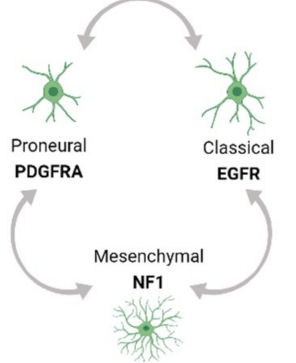
Figure 1. Different transcritptional subtypes of GBM cells and their associated mutations in bold. scRNA seq studies have elucidated three different subtypes of GBM cells namely Proneural (PN), Classical (CL), and Mesenchymal (MES) subtypes manifesting the PDFRA, EGFR and NF1 mutations